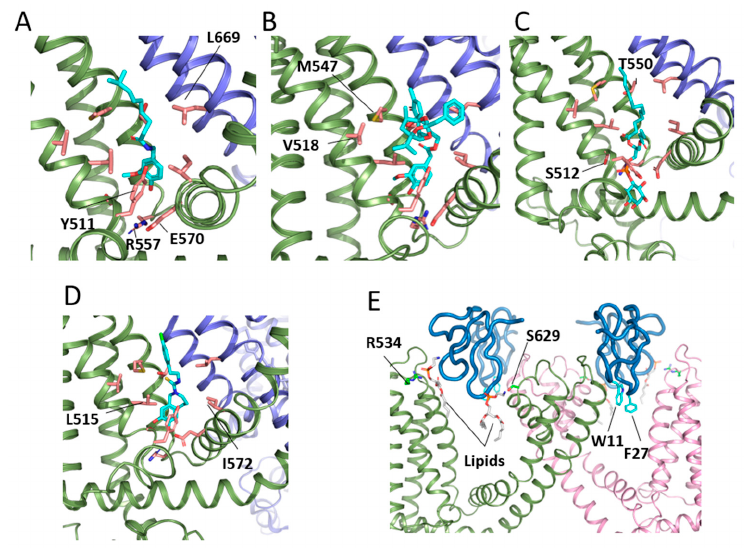
Figure 4. TRPV1 effectors at their binding sites. Panel ( A ) shows a detail of the capsaicin bound to the site (PDB code: 7LR0 [63]), together with the main residues involved in binding. ( B ) Resiniferatoxin (PDB code: 5IRX [46]). ( C ) PIP 2 (PDB code: 7MZ6 [14]). ( D ) Capsazepin (PDB code: 5IS0 [46]). Residues shown in panels ( A – D ) are the same: Y511, T550, S512, R557, E570, L515, V518, M547, and I572 from one monomer, as well as L669 from the adjacent monomer. All effectors are colored in cyan. ( E ) Two molecules of tarantula toxin (DkTx) bound to the extracellular face of TRPV1 (PDB code: 5IRX [46]). The toxin is colored in blue marine, showing the two main residues inserted in the membrane (W11 and F27, in cyan). Residues R534 and S626 (in green) interact with the head group of phospholipids also involved in toxin